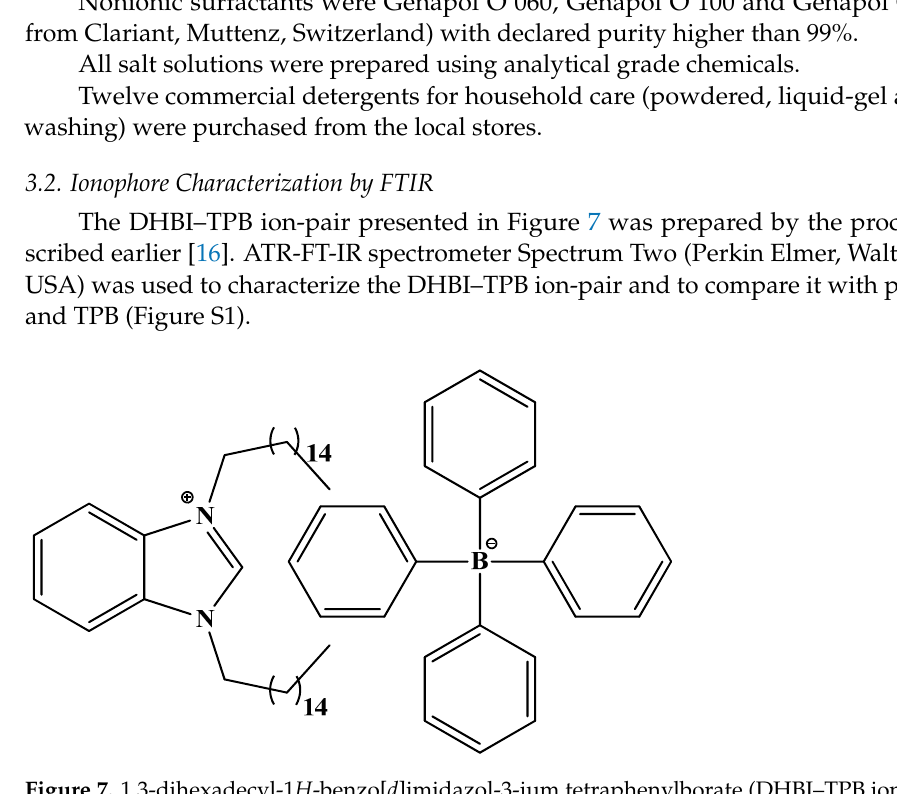
Figure 7. 1,3-dihexadecyl-1 H -benzo[ d ]imidazol-3-ium tetraphenylborate (DHBI–TPB ion-pair).